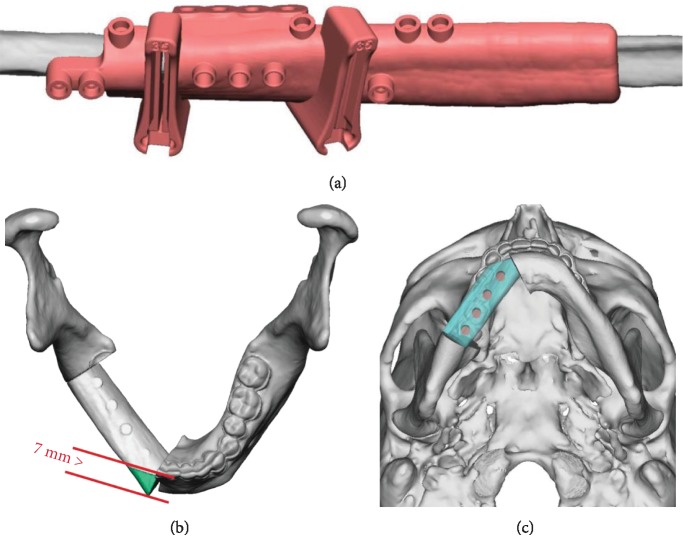
Showing virtual plan. (a) Fibula cutting guide. (b) Planned mandibular reconstruction with single segment fibula, superior view. (c) Mandibular reconstruction with fibula and immediate implants, submental view.